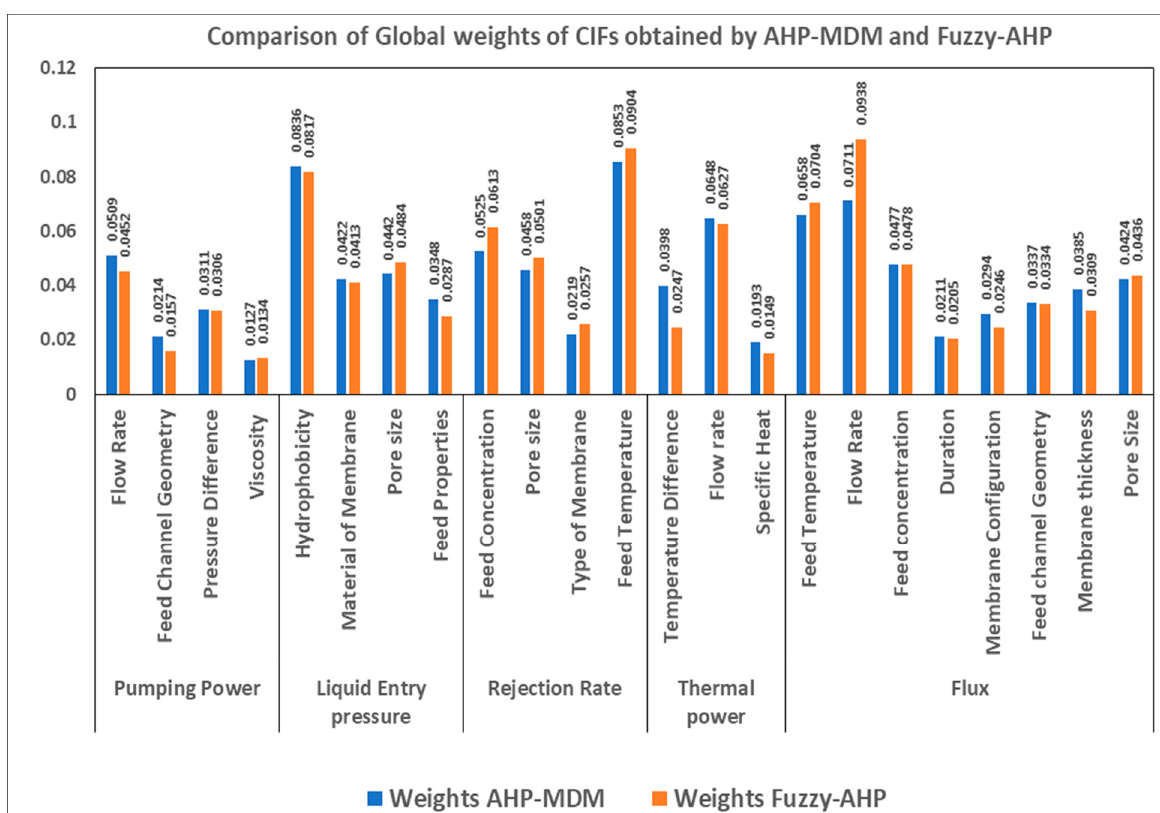
Figure 4. Comparison of weights of CIFs of membrane distillation obtained using AHP-MDM and Fuzzy-AHP.